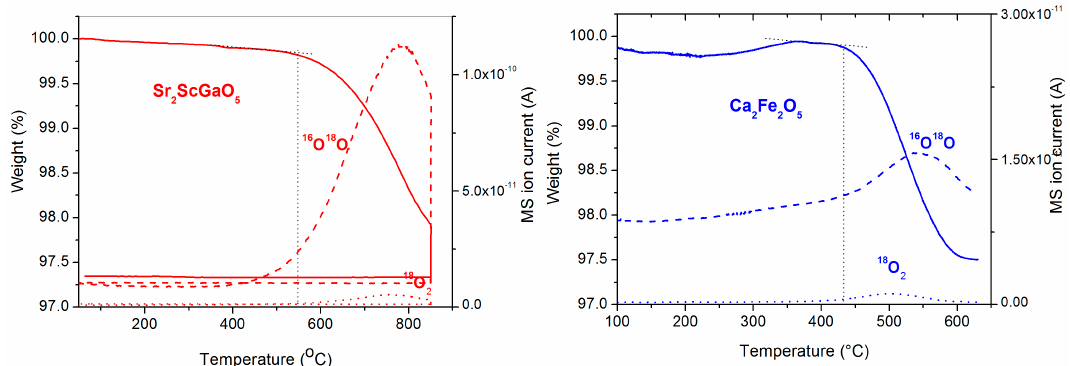
Figure 10. Oxygen isotope exchange behaviour of cubic Sr 2 ScGa 18 O 5 ( left ) and Ca 2 Fe 218 O 5 ( right ) followed by TG with a heating rate of 5 °C/min. The mass loss is related to the exchange of 18 O to 16 O, indicating that oxygen exchange is taking place as a solid/gas exchange reaction. For a 100% enrichment, the theoretical mass loss is 2.65% and 3.67% for c-SSGO and CFO, respectively. The 18 O/ 16 O exchange is indicated by simultaneously-measured mass signals corresponding to 18 O- 16 O and 18 O- 18 O.